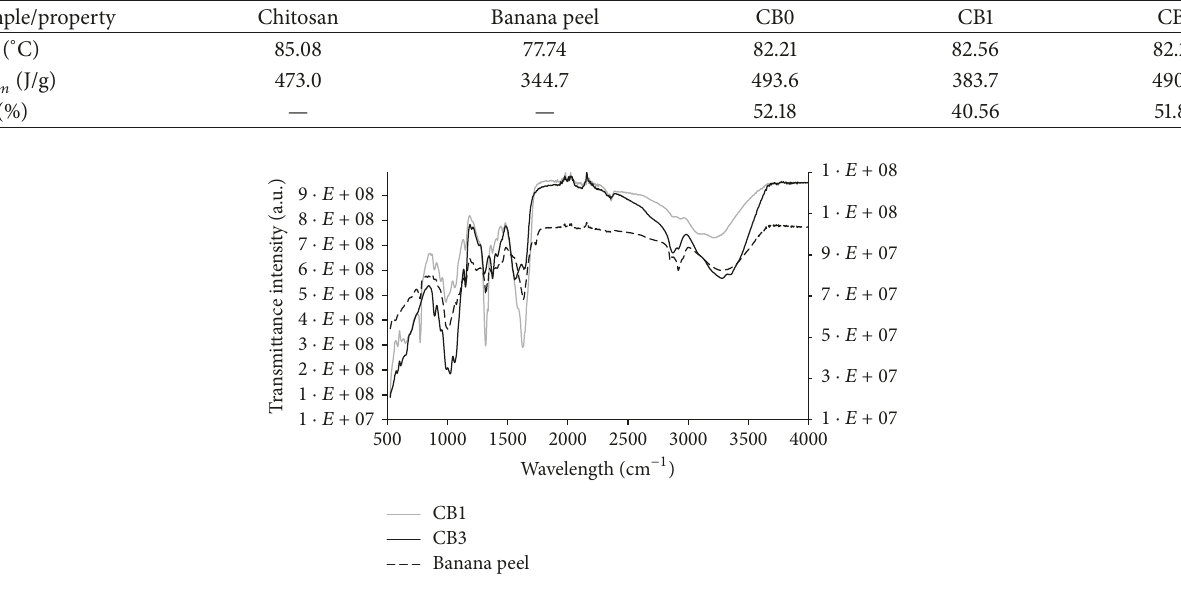
Figure 3: FTIR spectra of unripe banana peel and chitosan membranes prepared with the extracts of banana peel: (dashed) banana peel; (grey) chitosan membrane prepared with the first extract, CB1; and (black) chitosan membrane prepared with the third extract, CB3. Banana peel data is shown in the secondary transmittance intensity